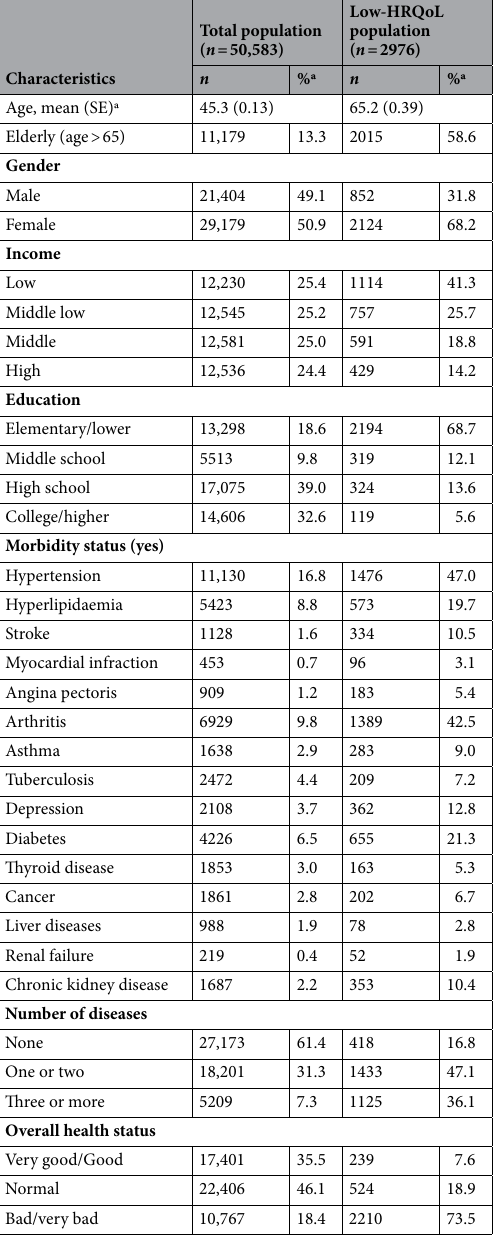
Table 1. Demographic and disease characteristics of the low-HRQoL population versus the total survey population. HRQoL , Health-related Quality of Life; SE Standard error. ªWeighted